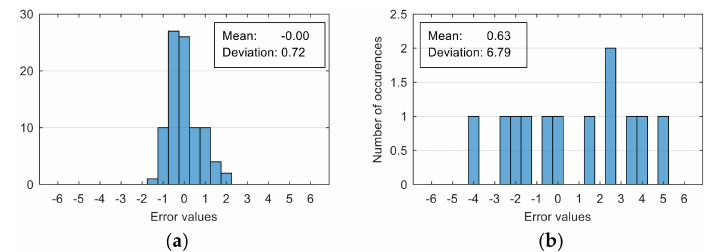
Figure 8. Estimation errors distribution for an improper data set split and 7 features ( a ) for identification subset; ( b ) for validation